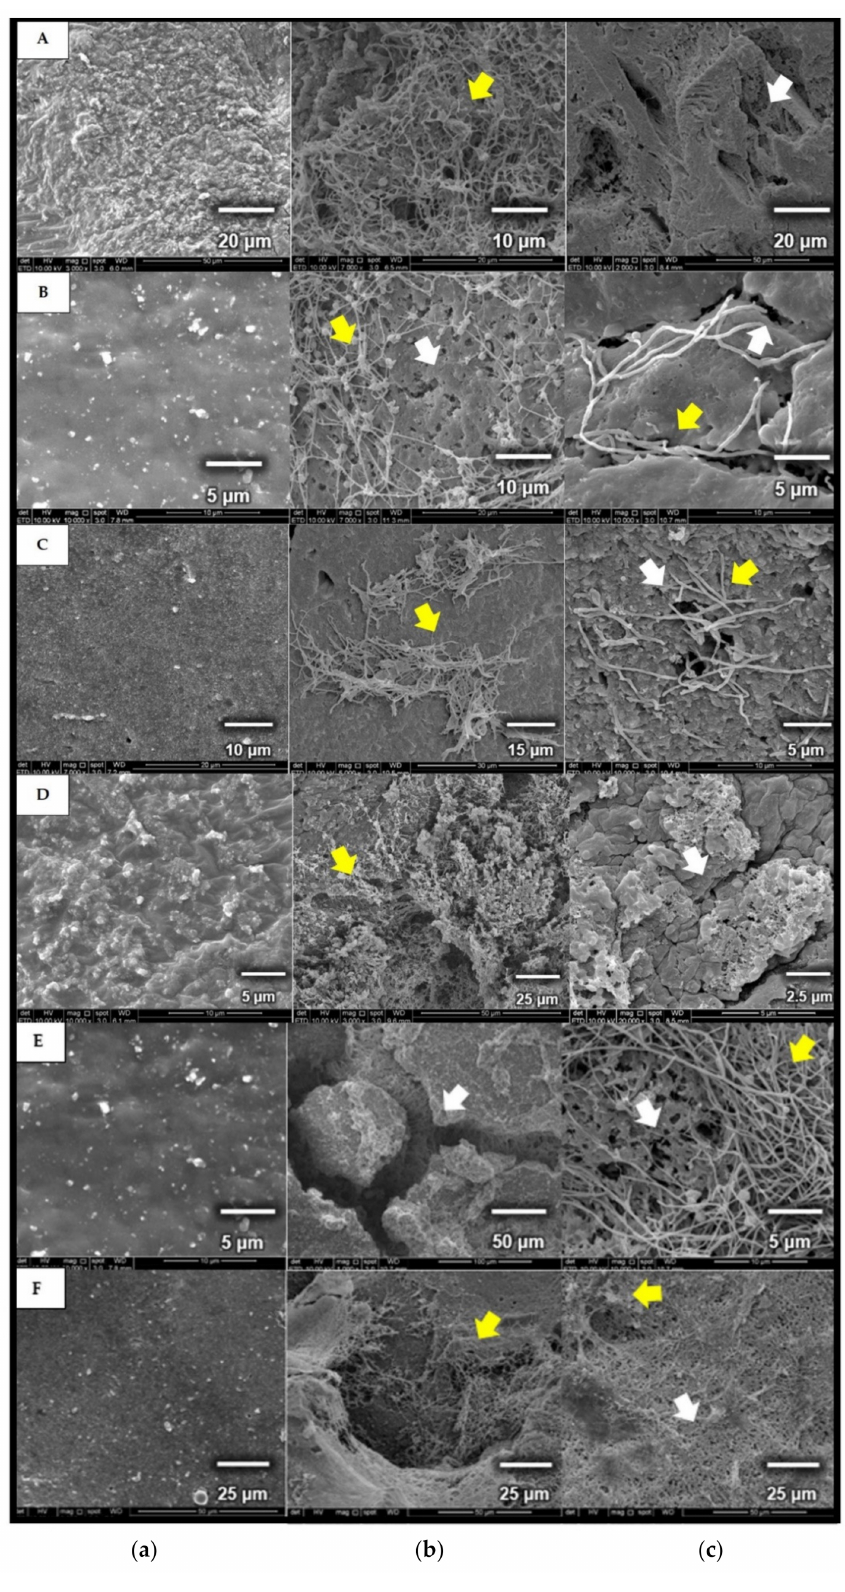
Figure 7. Micrographs of ( a ) control, rubber samples without microbial cultivation (A & D: fresh latex pieces; B & E: latex glove pieces; C & F: tyre granules); ( b , c ) rubber samples used as carbon source for cultivating Microtetraspora sp. AC03309 (A,B,C) and Dactylosporangium sp. AC04546 (D,E,F), incubated for 30 days, 28 ◦ C at 180